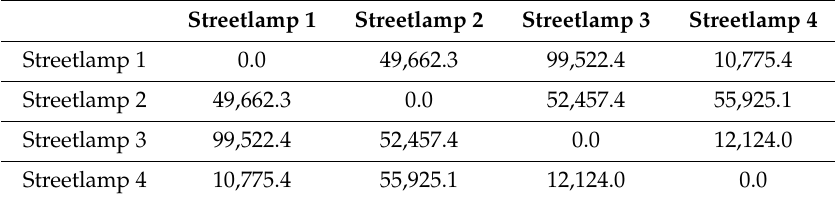
Table 7. Distances (mm) measured by the laser distance sensor of the MMS